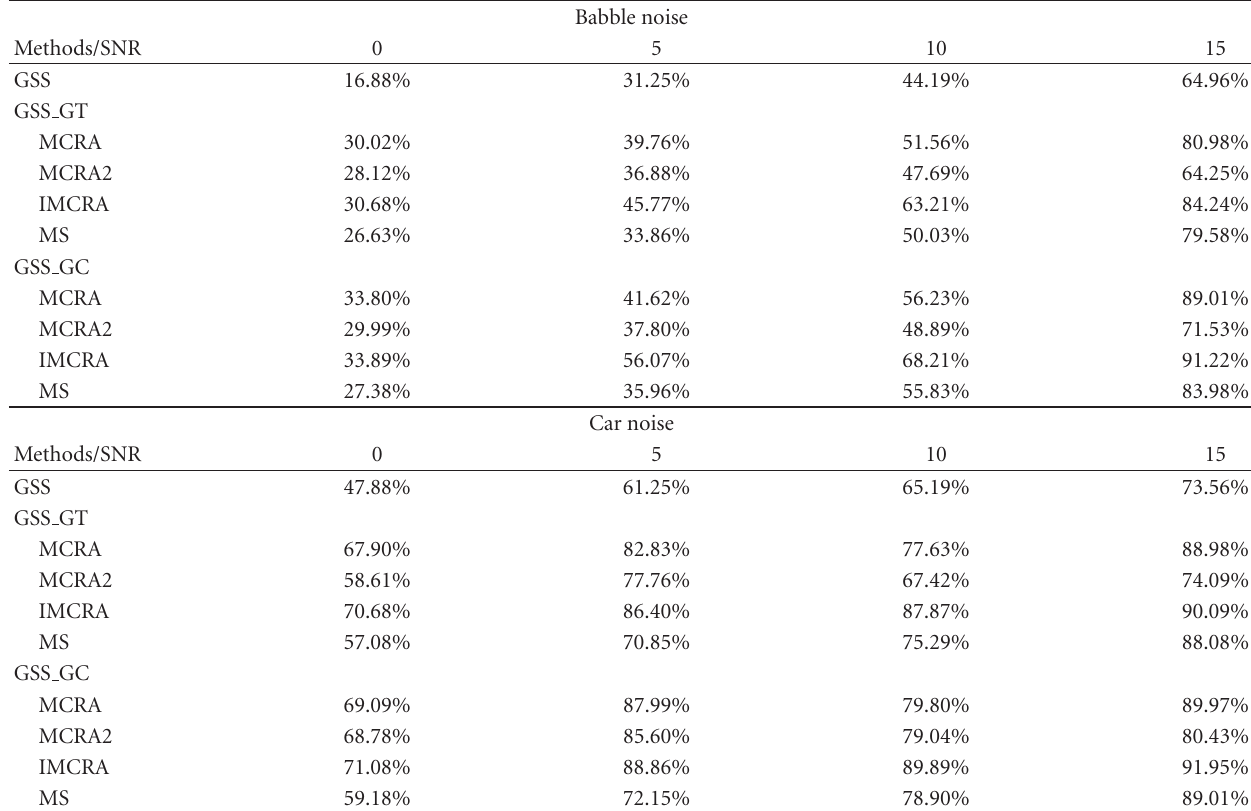
Table 2: Recognition rate for the proposed perceptual generalized spectral subtraction method based on the gammatone and the gammachirp filter banks decomposition (GSS GT and GSS GC) compared with the spectral subtraction rule